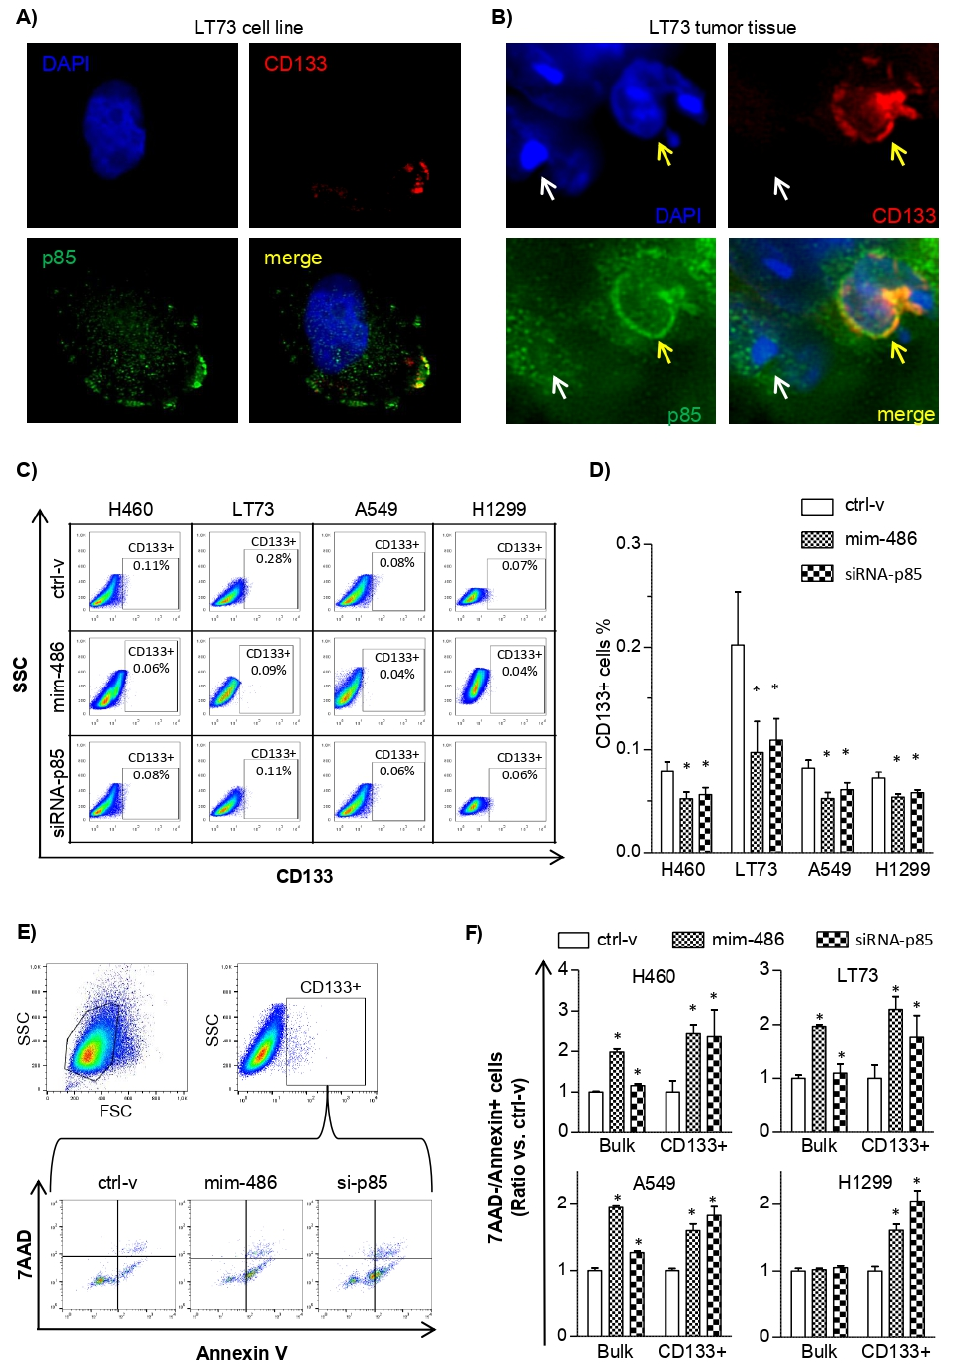
Figure 3. miR-486-5p reduces CD133+ lung cancer stem cells through the regulation of the p85/AKT pathway. ( A , B ) Immuno-fluorescence assay evidences the co-localization of CD133 (PI, red) and p85 (FITC, green) on the membrane of CD133+ lung cancer stem cells in the LT73 cell line and in the LT73 original tumor tissue. In panel B, CD133+ cell is indicated by the yellow arrow and CD133– cell by the white arrow. ( C , D ) Flow-cytometry analysis of CD133+ cells in lung cancer cell lines transfected with the control vector (ctrl-v), mim-486, and siRNA-p85. ( E ) Gating strategy to evaluate 7AAD and Annexin expression in LT73 CD133+ cell lines. ( F ) Percentage of Annexin+ cells in lung cancer cell lines transiently transfected with the control vector (ctrl-v), mim-486, and siRNA-p85. For all the experiments, 48 h after transient transfection was selected as time point. *: p < 0.05 vs